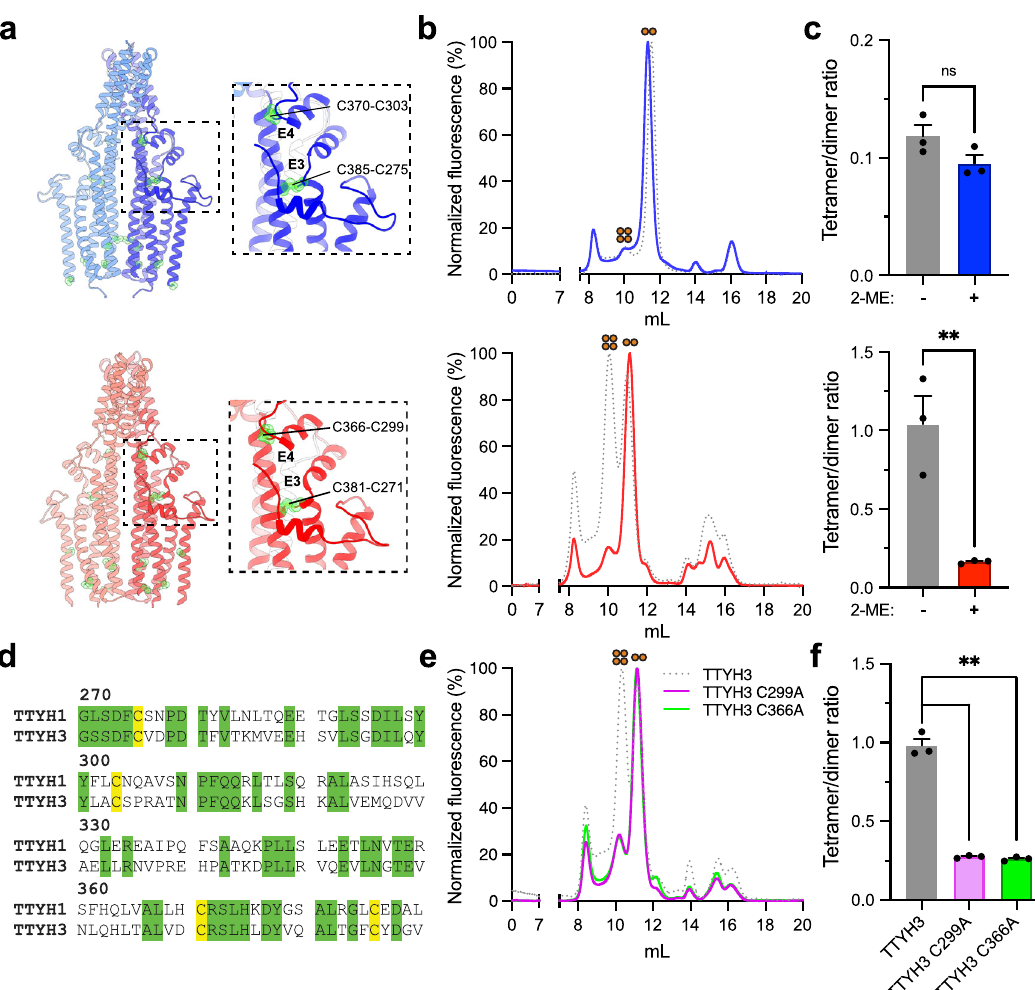
Fig. 5 mTTYH disul fi des contribute to tetramerization. a Cryo-EM structures of hTTYH1 (upper panel; PDB: 7P5J) and hTTYH3 (lower panel; PDB: 7P5C) in cartoon representation. The dashed rectangles frame zoom perspectives of the disul fi de bridges within the ECDs. Cysteine residues are colored green and shown as spheres. b FSEC chromatograms depicting the elution pro fi les of DDM solubilized HEK 293 cells expressing the indicated EGFP-fused mTTYH1 (upper panel) and mTTYH3 (lower panel) before (gray curve) and following incubation with 20 mM 2-ME (colored curve). c Tetramer/dimer ratio of mTTYH1 (upper panel) and mTTYH3 (lower panel) before and following incubation with 2-ME. d Protein sequence alignment of the ECD region from mTTYH1 and mTTYH3, highlighting conserved positions and cysteine residues in green and yellow, respectively. e FSEC chromatograms depicting the elution pro fi les of mTTYH3 ECD cysteine mutants. f Tetramer/dimer ratio of the mTTYH3 ECD cysteine mutants. ( n = 3, t -test, ns non-signi fi cant, ** p